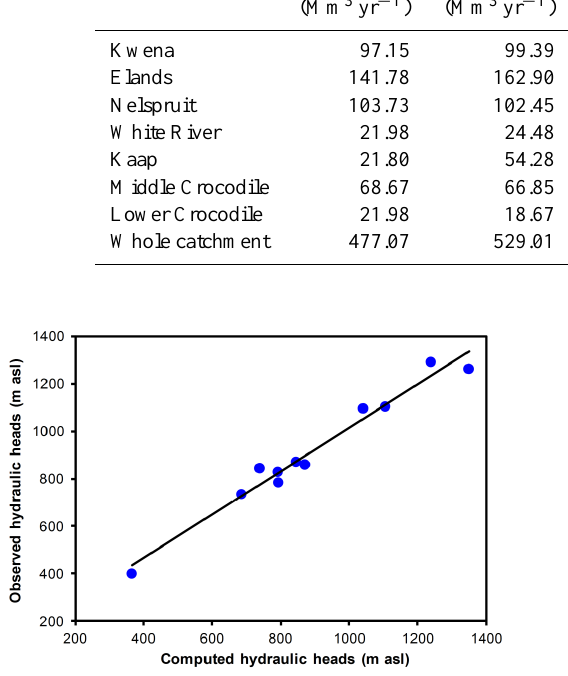
Figure 10. Scatter plot of the computed and observed groundwater